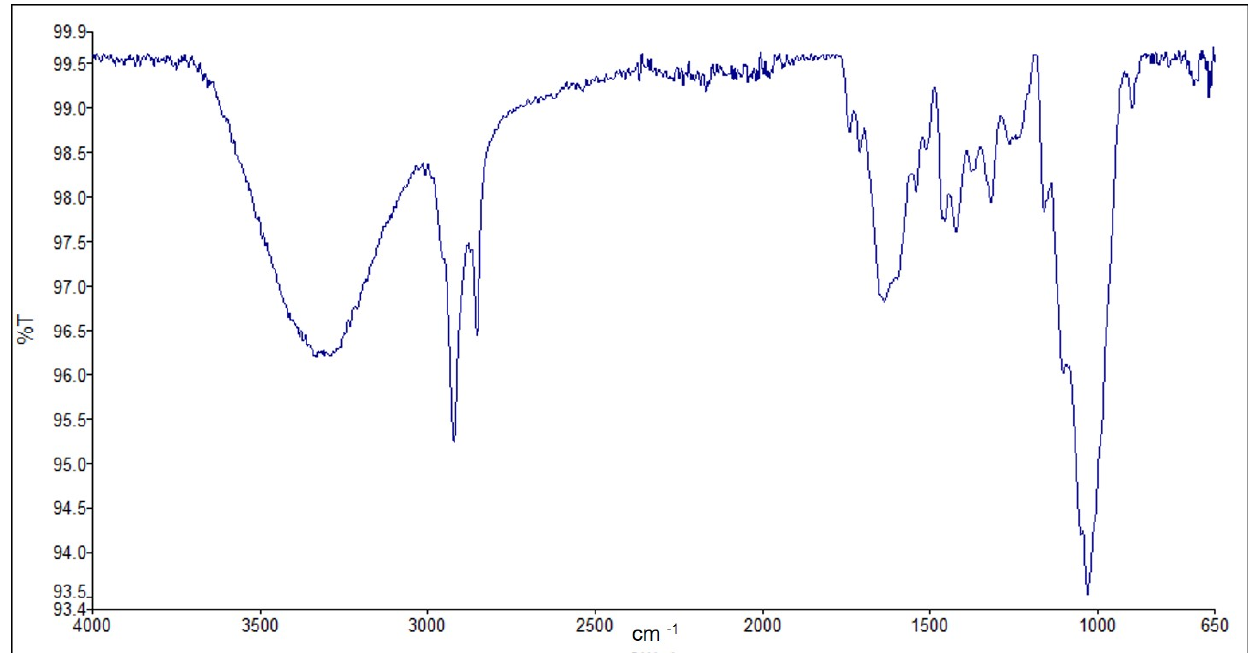
Figure 3. FTIR spectrum of Catalpa bignonioides fiber.